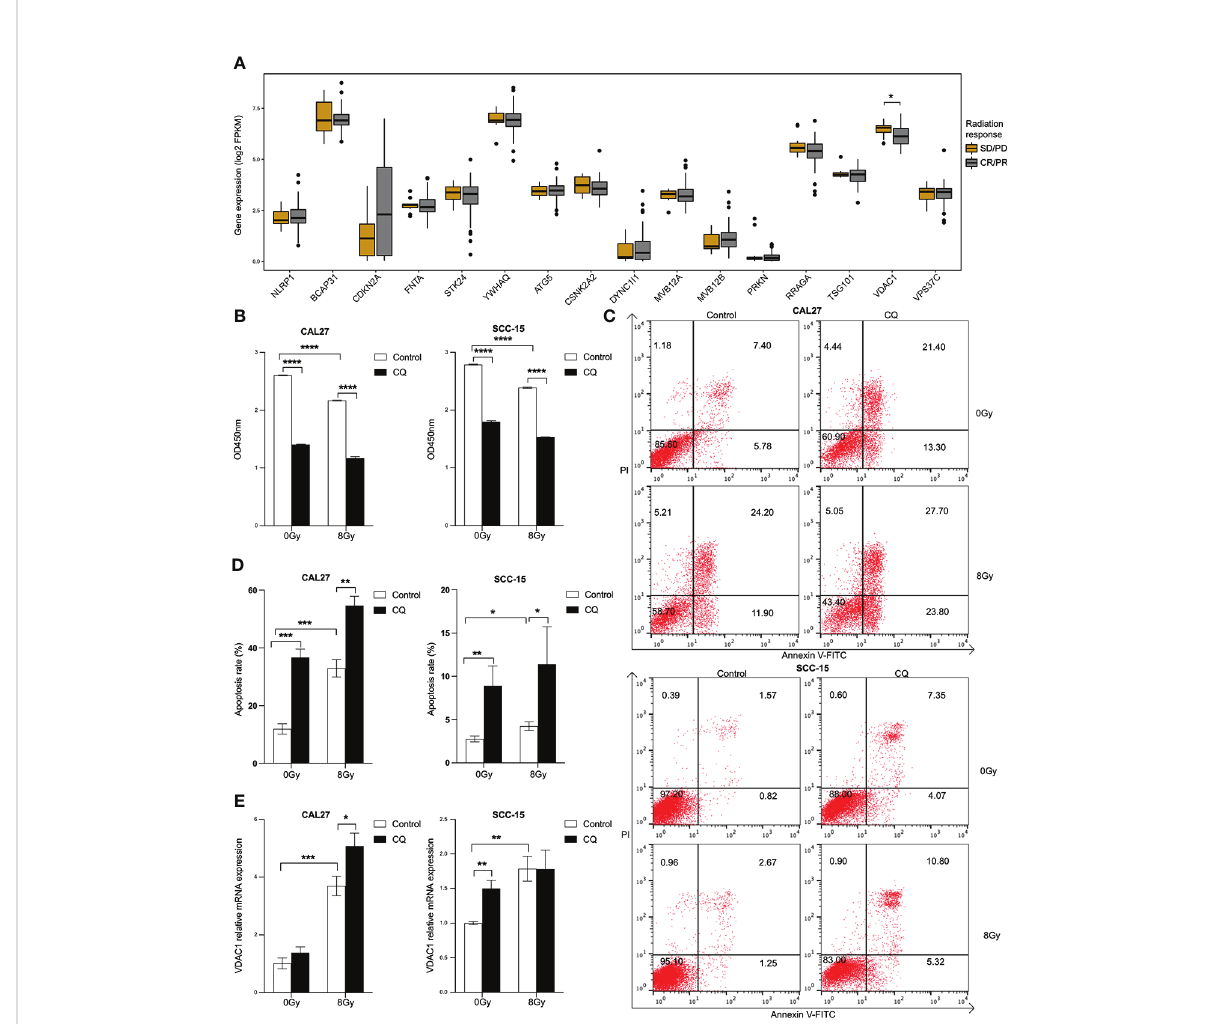
FIGURE 7 Radiation enhances the expression of VDAC1 in HPV negative HNSCC cell lines. (A) Boxplots of the expressions of 16 overall survival associated genes between radiation sensitive and resistant subgroups in HPV negative HNSCC. (B) Cell proliferation after chloroquine treatment for 24 h, following radiation in CAL27 and SCC-15 cell lines. (C, D) Cell apoptosis post chloroquine and/or radiation treatments in CAL27 and SCC-15 cell lines indicated by annexin V and PI using fl ow cytometry. (E) VDAC1 transcript post chloroquine and/or radiation treatments in CAL27 and SCC- 15 cell lines. HNSCC: head and neck squamous cell carcinoma; HPV: human papillomavirus; CQ: chloroquine. Each bar represents the mean ± SD. Statistical signi fi cance is assessed by Student ’ s t test. * P < 0.05, ** P < 0.01, *** P < 0.001, **** P <